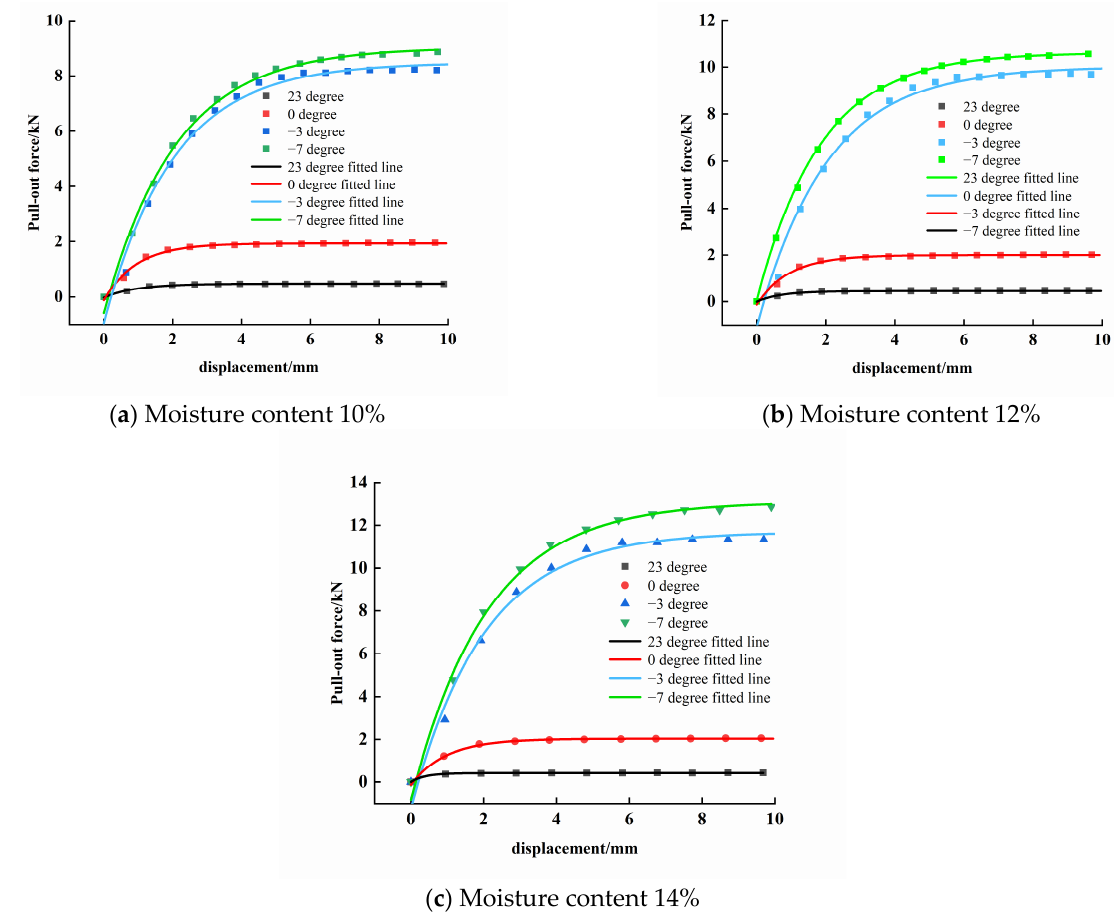
Figure 15. Pull-out force vs. displacement at different temperatures.